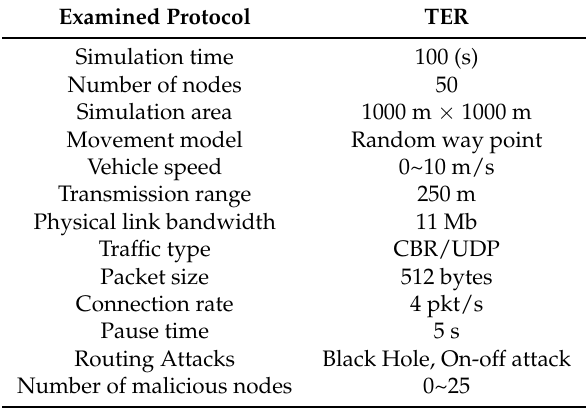
Table 3. Simulation parameters in trust enhanced